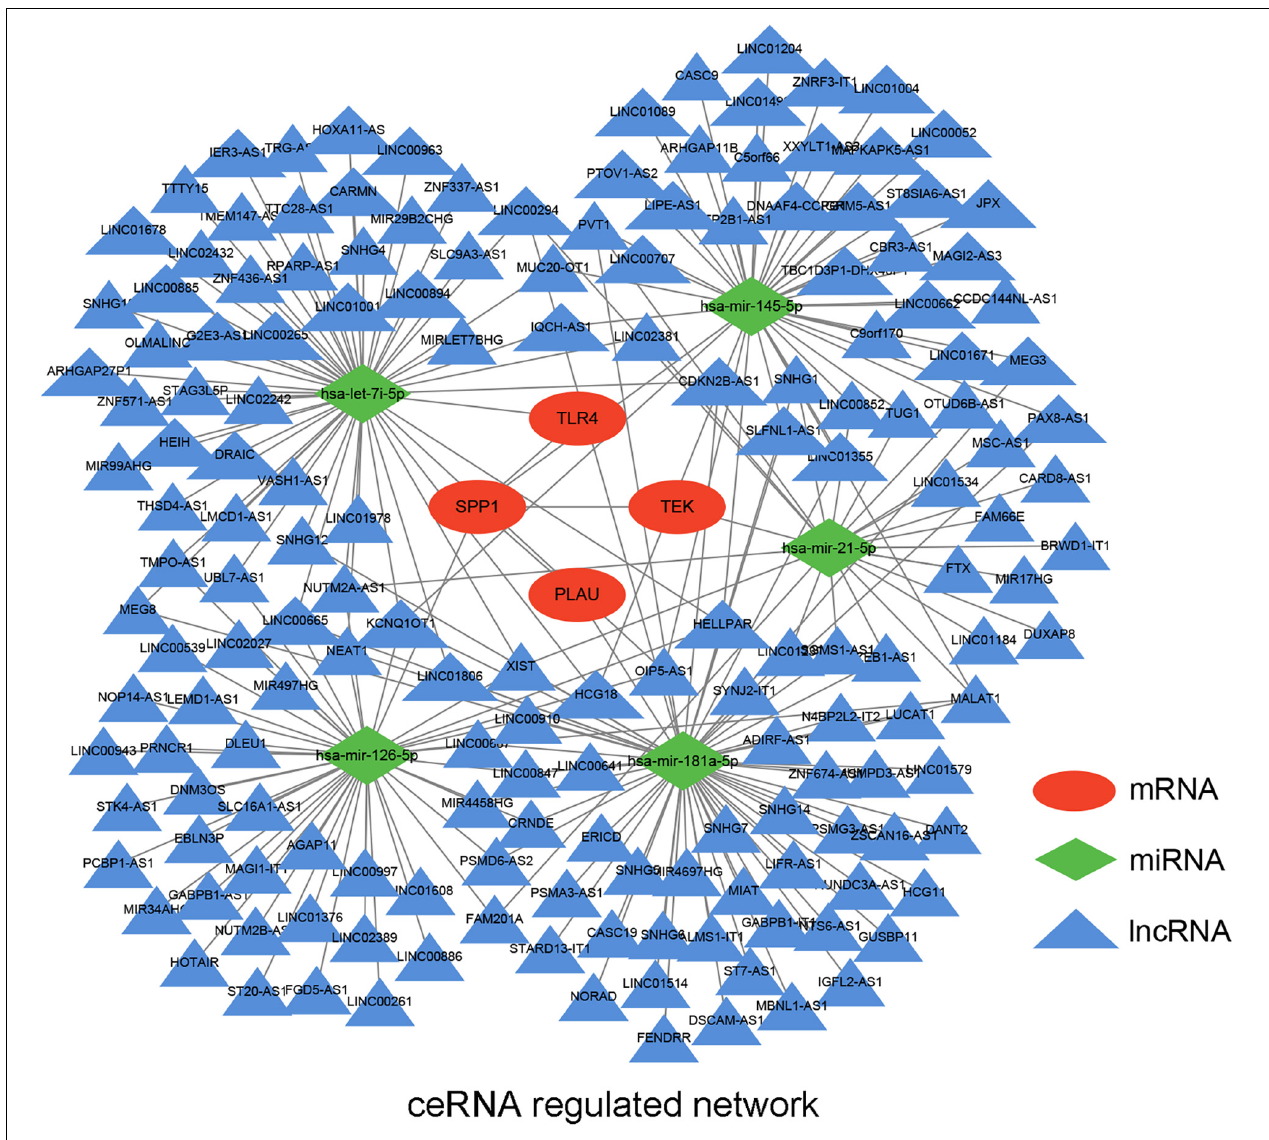
FIGURE 6 | The potential mRNA-miRNA-lncRNA regulatory network related to LUAD immune signature. The ellipse, diamond, and triangle shape represent mRNA, miRNA, and lncRNA,